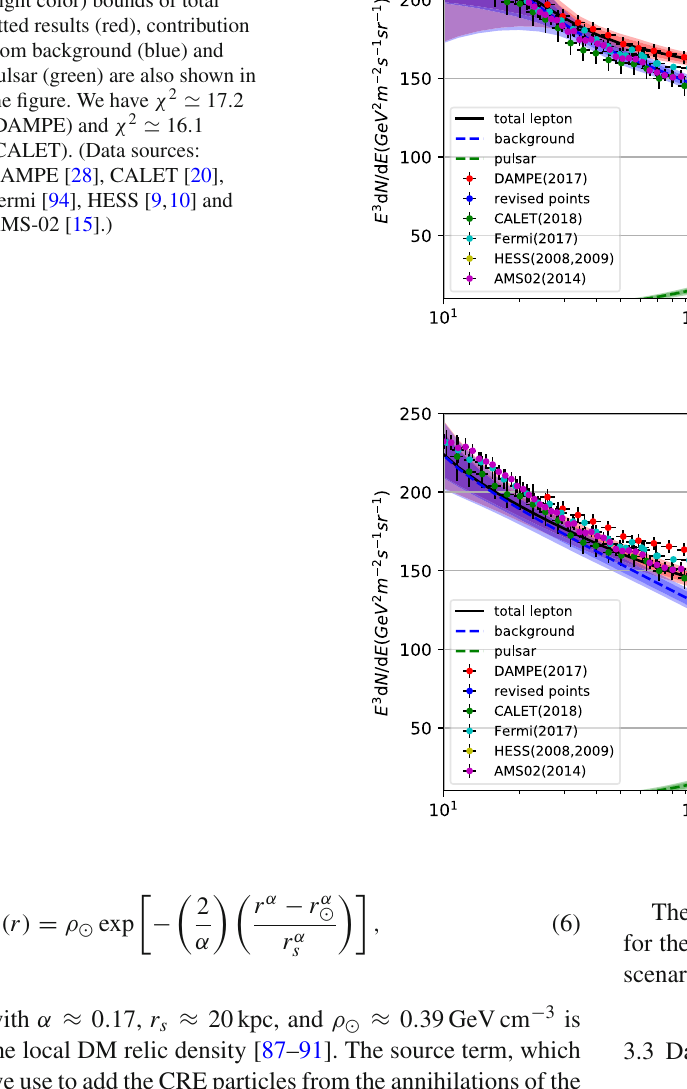
Fig. 1 The global fitting results of the DAMPE and CALET lepton flux for pulsar scenario. The 2 σ (deep color) and 3 σ (light color) bounds of total fitted results (red), contribution from background (blue) and pulsar (green) are also shown in the figure. We have χ 2 (cid:2) 17 .